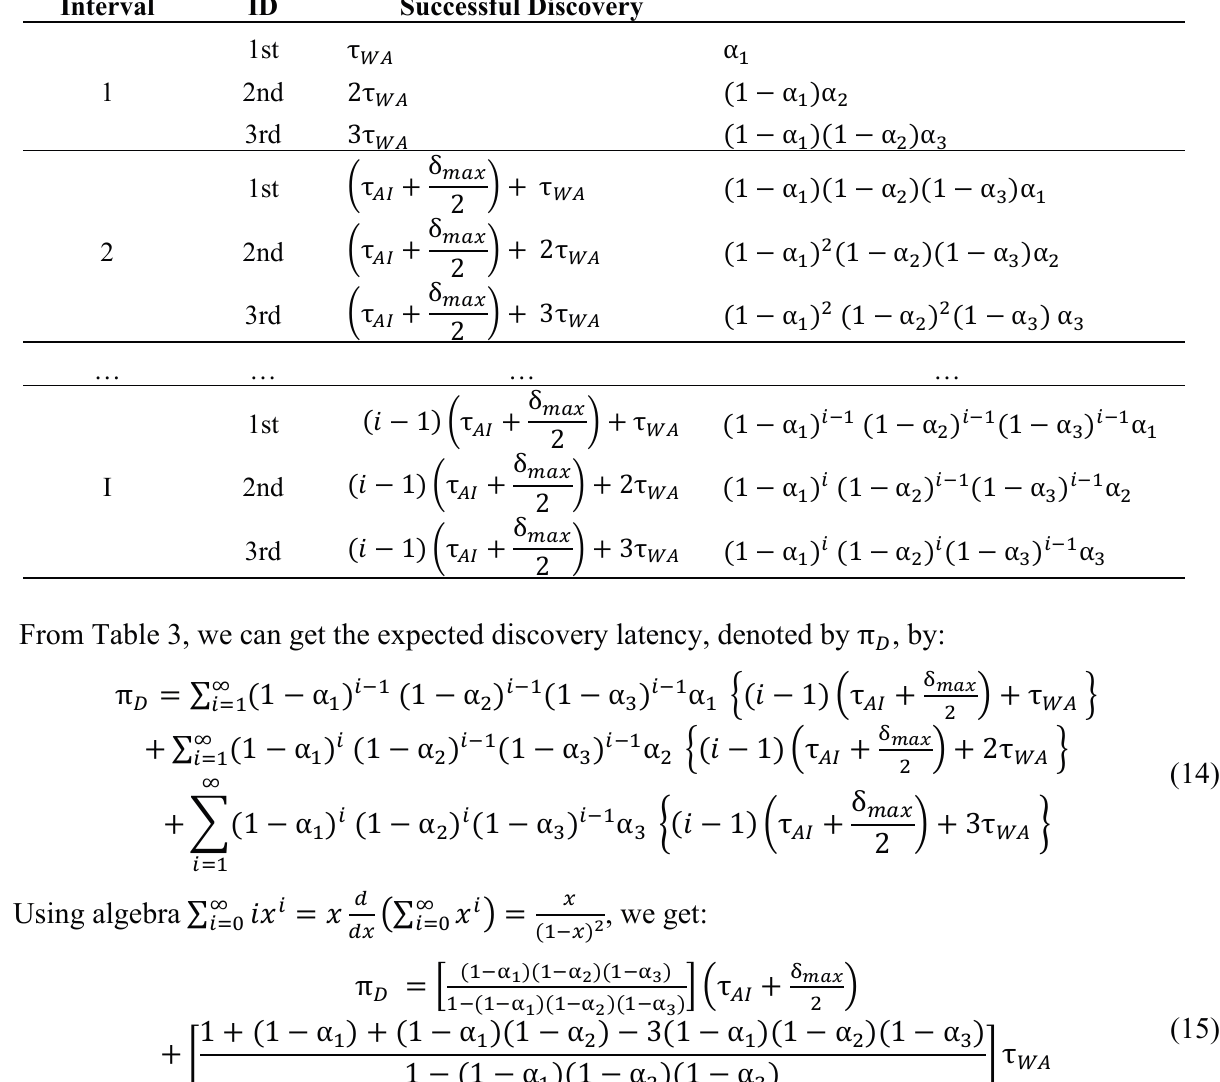
Table 3. Elapsed time to successful discovery and the corresponding probability.